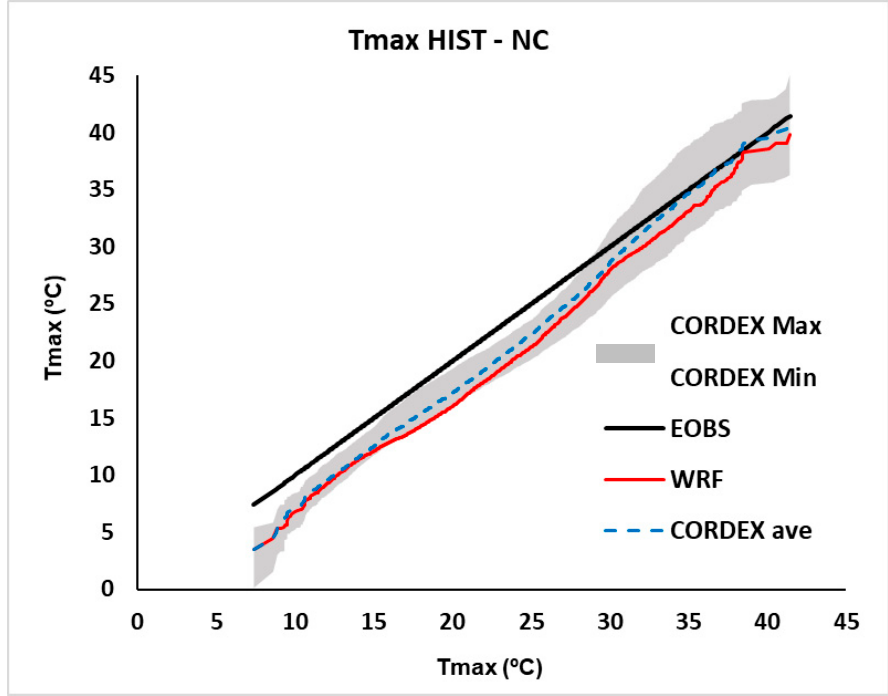
Figure 4. Quantile–quantile graph of Tmax for EOBS, WRF NC, and CORDEX NC ensemble average (CORDEX ave), and maximum and minimum (gray shading). EOBS is represented in the x-axis and the models in the